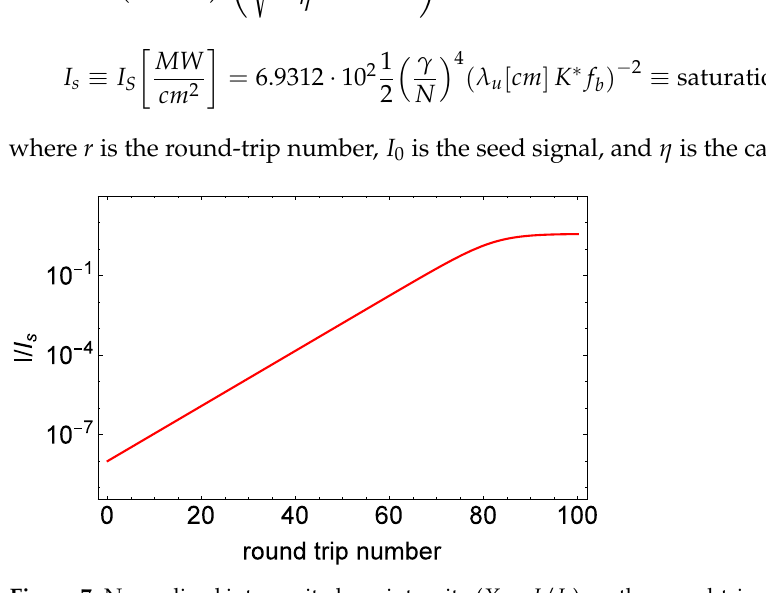
Figure 7. Normalized intracavity laser intensity ( X = I / I s ) vs. the round-trip period. For an oscillator operating with the parameters of Table 1 and with total losses η ∼ =